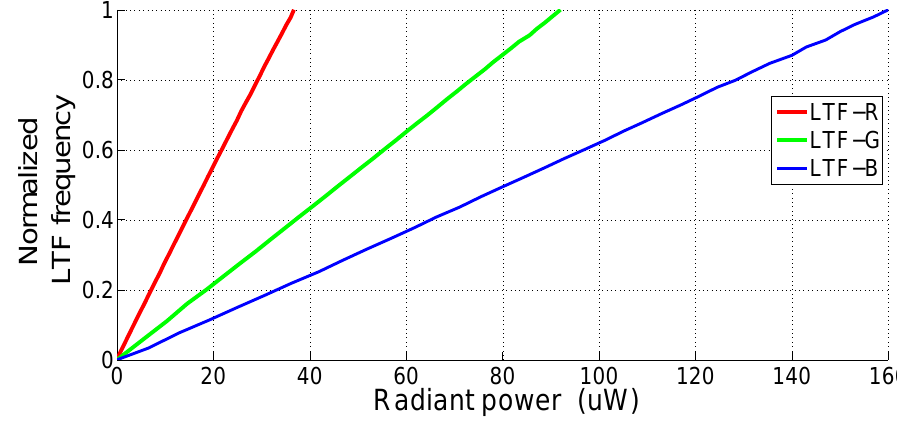
Figure 6. Response of the LTF frequency to RGB